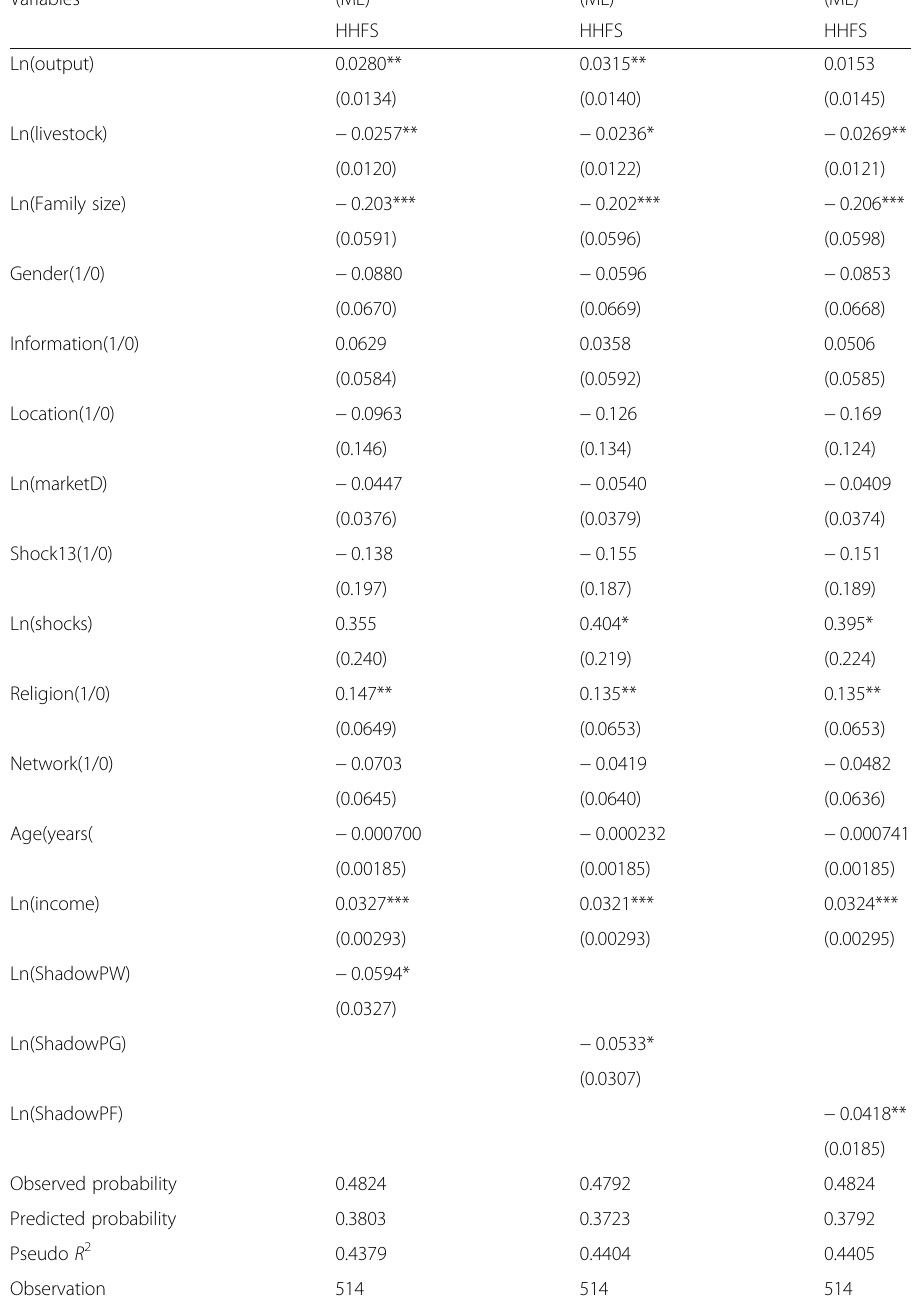
Table 6 Probit estimation of food security using walking distance